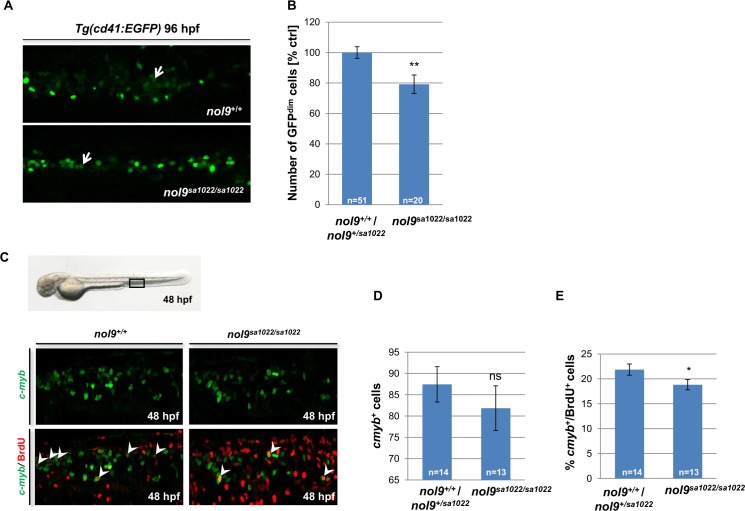

nol9
sa1022/sa1022 mutants show a decrease in proliferation of c-myb
+ cells.(A) Representative maximum projection confocal images showing HSPCs (GFPdim, arrow) in the CHT of Tg(cd41:EGFP) larvae at 96 hpf. Larvae are oriented with anterior to the left and dorsal to the top. (B) The number of GFPdim HSPCs observed in the CHT region of nol9
sa1022/sa1022 mutants (n = 20) and their wt siblings (n = 51) at 96 hpf. Data are represented as the mean +/- SEM, Student’s t-test, **, p<0.01. (C) Representative confocal images of the CHT of Tg(cmyb:EGFP) embryos subjected to BrdU incorporation assay at 48 hpf. Arrowheads mark double positive BrdU+
c-myb
+ cells. Bright field image of a 48 hpf embryo shows the imaged part of the CHT. (D) The total number of c-myb
+ cells observed in the CHT of nol9
sa1022/sa1022 embryos (n = 13) and their wt siblings (n = 14) subjected to the BrdU incorporation assay at 48 hpf. Data are represented as the mean +/- SEM. Student’s t-test. ns—not significant. (E) The percentage of BrdU+ cells within the c-myb
+ population in the CHT of nol9
sa1022/sa1022 embryos (n = 13) and their wt siblings (n = 14) subjected to the BrdU incorporation assay at 48 hpf. Data are represented as the mean +/- SEM, Student’s t-test, *, p<0.05.